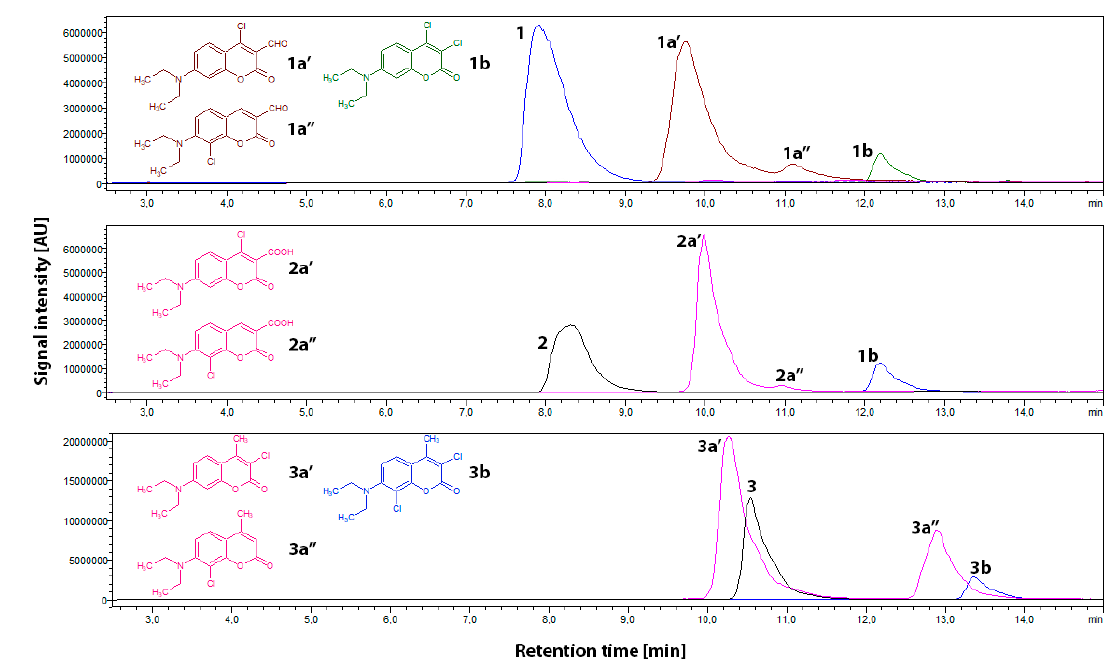
Figure 4. HPLC-MS traces and proposed structures of chlorination products of 150 µ M probes 1 – 3 by 150 µ M of NaOCl at pH 3 and a temperature of 25 ◦ C. Peak numbering is presented in Table 1. (The remaining HPLC-MS data are given in the supplementary information).